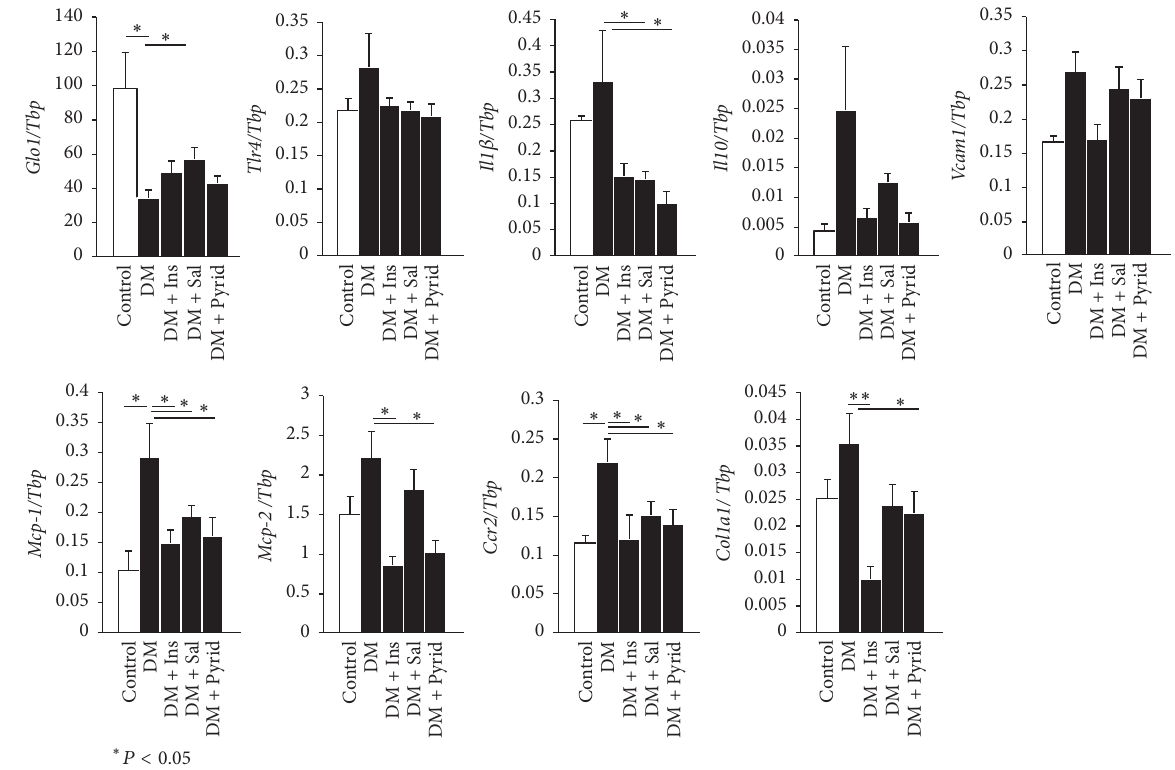
Figure 6: Gene expressions of kidneys. The mRNA expression levels were measured by qRT-PCR and normalized to TATA-binding protein ( Tbp ). Following primer sets were used for the detection (Table 1): glyoxalase 1 ( Glo1 ), toll-like receptor 4 ( Tlr4 ), interleukin ( Il ) 1b , Il10 , vascular cell adhesion molecule- ( Vcam- ) 1 , monocyte chemoattractant protein- ( MCP-) 1 , Mcp-2 , C-C chemokine receptor type 2 ( Ccr2 ), and collagen 1a1 ( Col1a1 ). Nondiabetic control (Control) ( 𝑛 = 8 ), diabetic mice without treatment (DM) ( 𝑛 = 19 ), diabetic mice with insulin treatment (DM + Ins) ( 𝑛 = 8 ), diabetic mice with salicylate treatment (DM + Sal) ( 𝑛 = 12 ), and diabetic mice with pyridoxamine treatment (DM + Pyrid) ( 𝑛 = 15 ). Values are mean ±